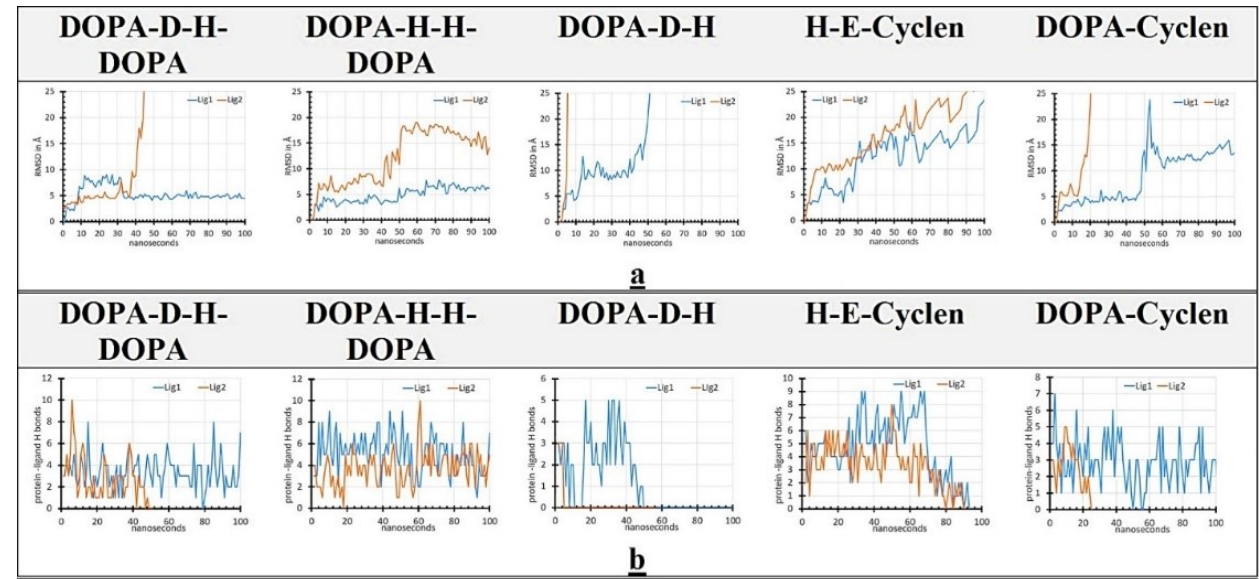
Figure 6. All-atom MD simulations of the binding interactions between S100A9 homodimer and DOPA and cyclen-based compounds. ( a ) RMSD values depicting the corresponding compound mobility in complex with S100A9 dimer over 100 ns. The ligands denoted as 1 and 2 are presented in order of their mobility on the protein surface; the least mobile ligand 1 is shown in blue and the more mobile ligand 2 is shown in orange, respectively. ( b ) Number of H-bonds between the corresponding ligands and S100A9 dimer. The color coding in ( b ) is the same as in ( a ).